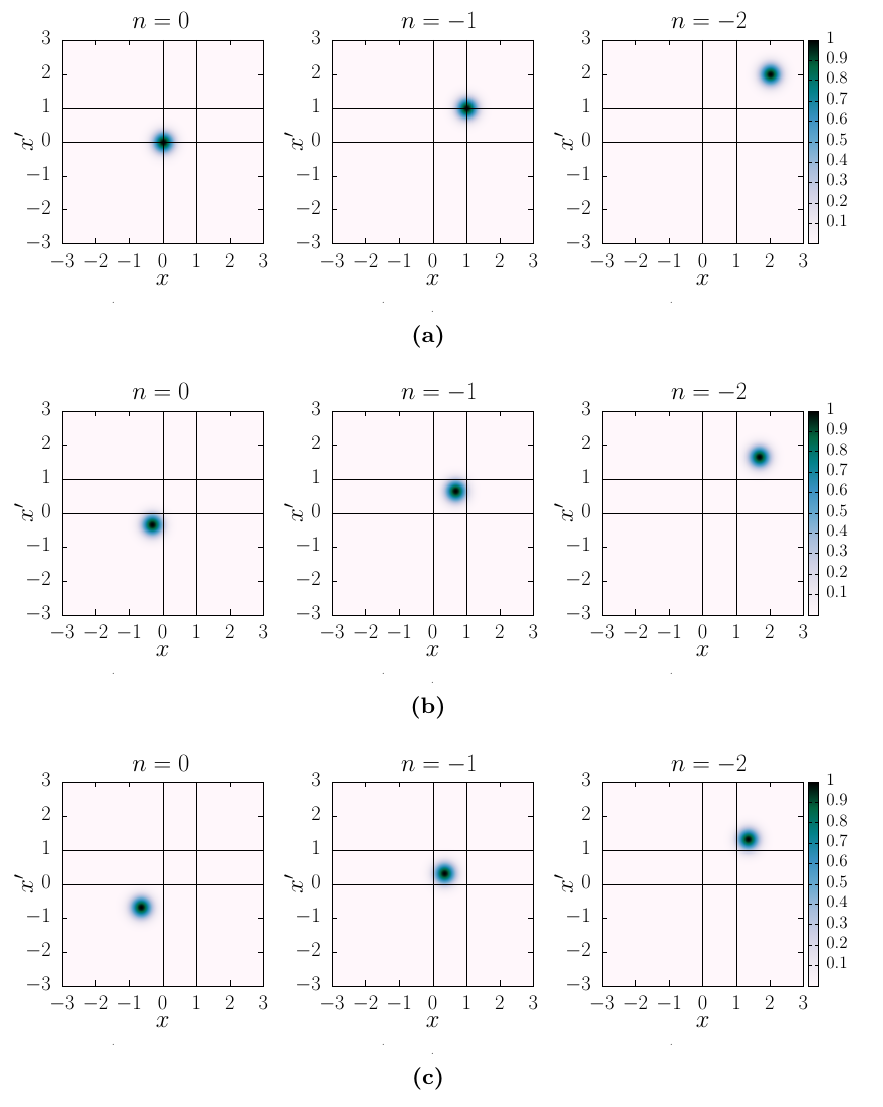
Figure 2. Contribution of the modes n = 0 ; eq. (3.4), for (cid:18) = 3 and (a) k = 0, (b) k = 1, (c) k =